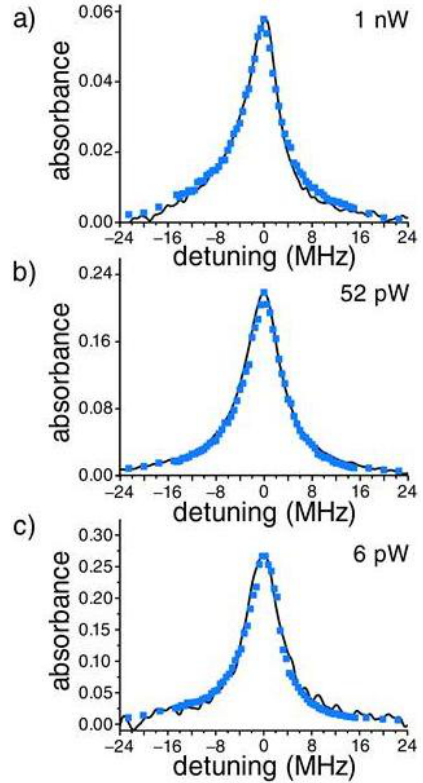
Figure 8. Line shapes obtained from an evanescent field around a nanofiber embedded in a laser-cooled sample of Cs. The measured linewidths approach the natural linewidth (6.2 MHz) for vanishing probe powers. Reprinted with permission from [57]. Copyright 2007 American Physical